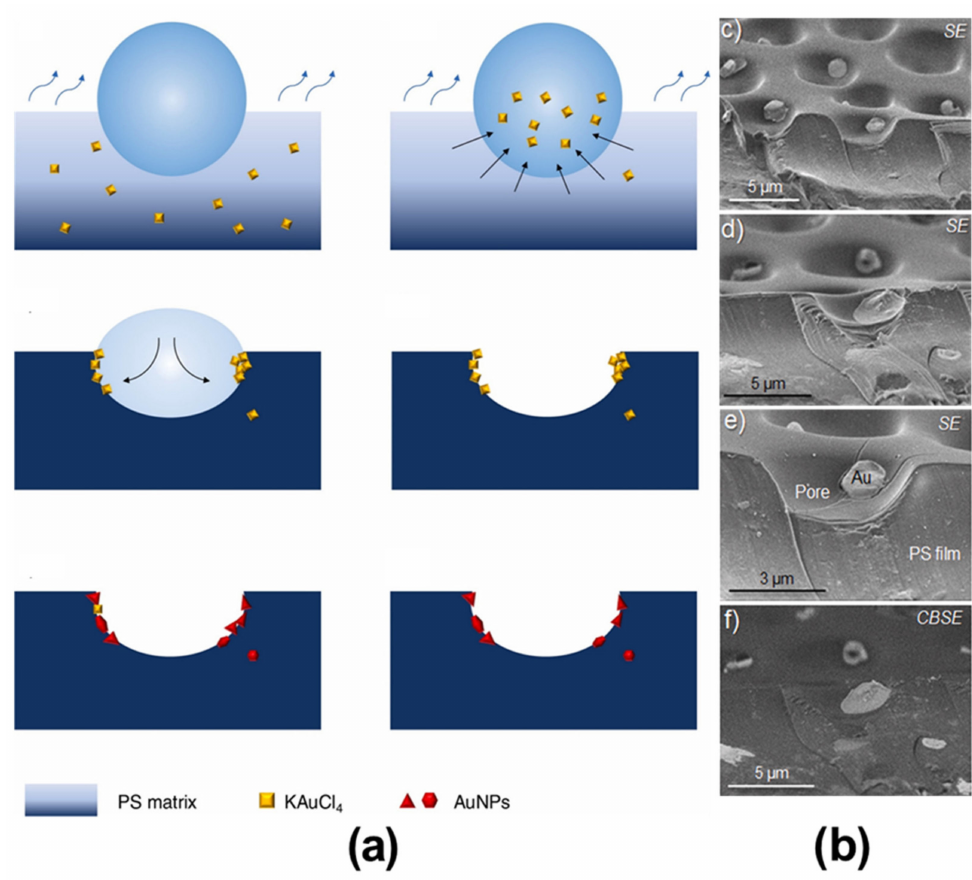
Figure 10. ( a ) Proposed formation mechanism of hybrid membranes with AuNPs inside the pores of the HCP film. ( b ) SEM analysis of sample Au5 after heating at 170 ◦ C for 5min, showing AuNPs present at the pores. Reprinted with permission from ref. [70]. Copyright 2021 Colloids and Surfaces A: Physicochemical and Engineering